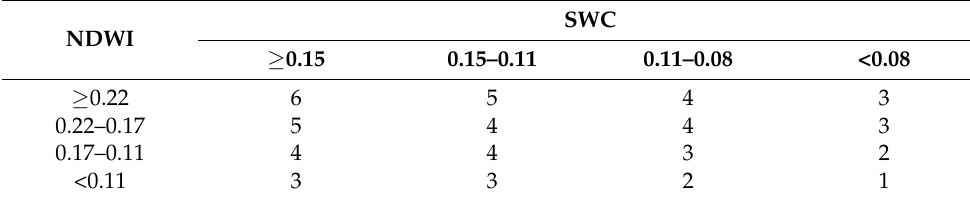
Figure 1. Schematics showing the two-tiered approach used in developing the irrigation advisory service. Abbreviations used are explained in the text. Table 1. Evaluation matrix for determination of the crop water availability index